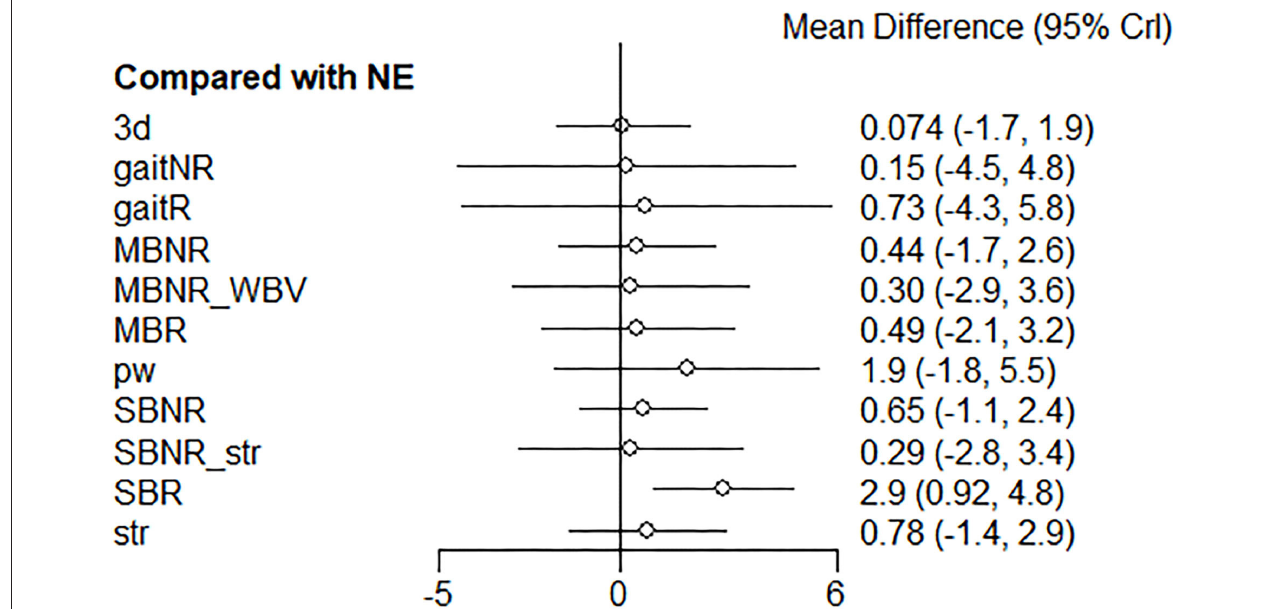
FIGURE 7 | Forest plot of the relative effects of exercise interventions with a no-exercise as a reference group in healthy older adults. SBR, Single balance exercise including reactive balance component; SBNR, Single balance exercise not including reactive balance component; MBR, Multiple balance exercises including reactive balance component; MBNR, Multiple balance exercises not including reactive balance component; gaitR, Gait training including reactive balance component; gaitNR, Gait training not including reactive balance component; WBV, Whole body vibration; str, Strength; pw, Power; 3d, 3D exercise; NE, No